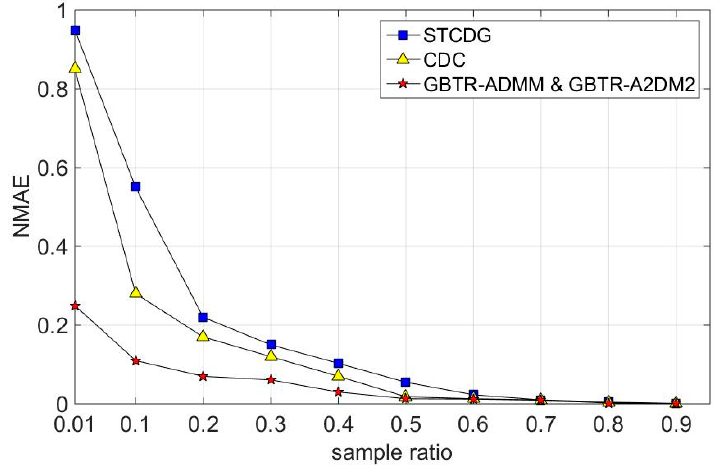
Figure 6. Recovery errors on temperature dataset.